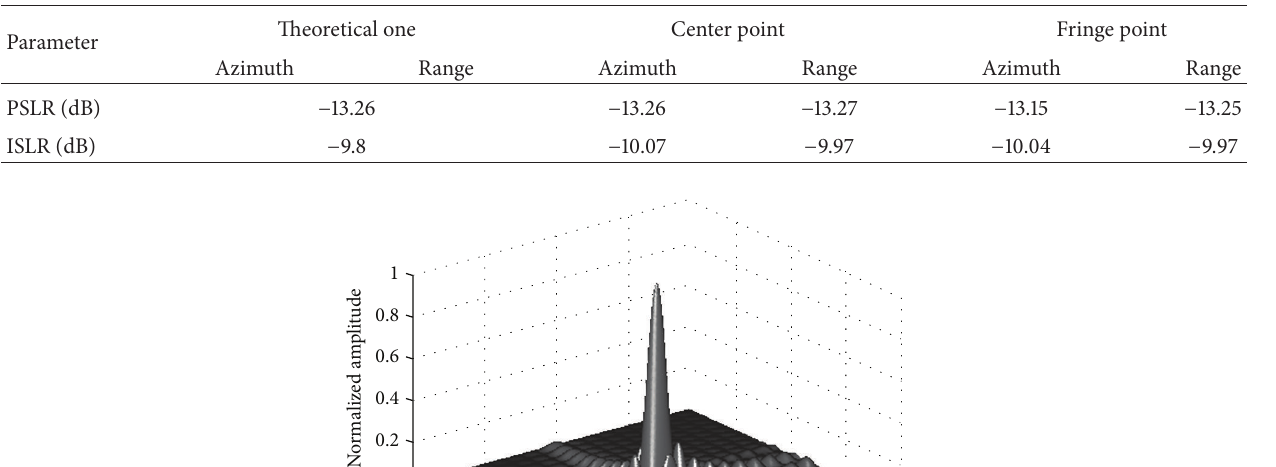
Table 2: Image quality parameters using the proposed method.